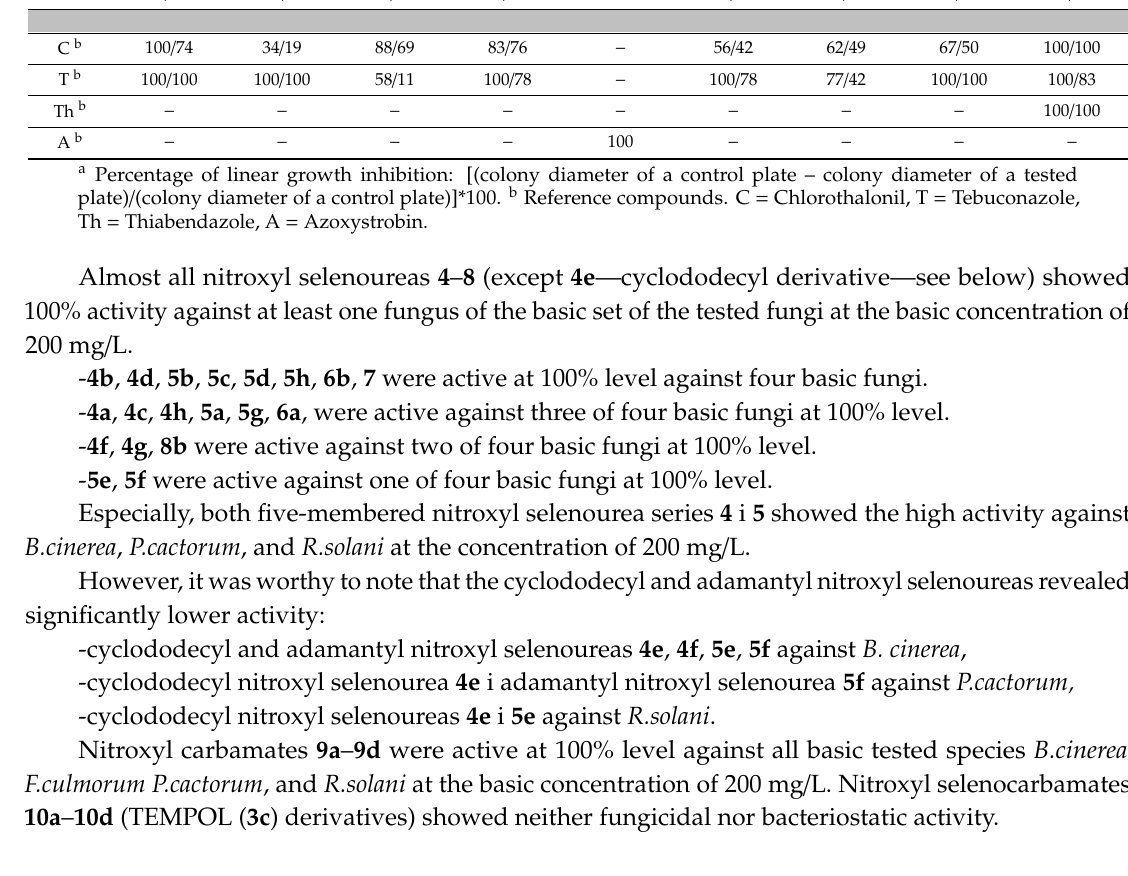
a Percentage of linear growth inhibition: [(colony diameter of a control plate – colony diameter of a tested plate) / (colony diameter of a control plate)]*100. b Reference compounds. C = Chlorothalonil, T = Tebuconazole, Th = Thiabendazole, A =